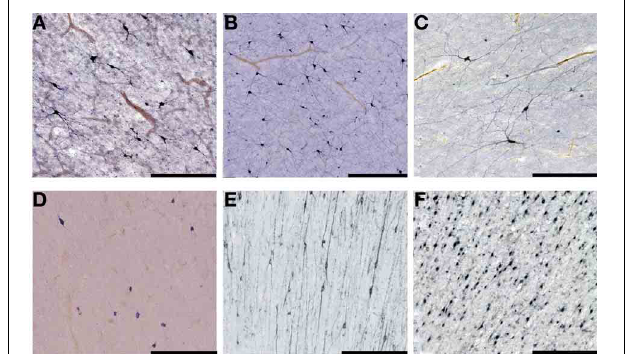
FIGURE 5 | Higher magnification view of subplate and white matter interstitial neurons displayed in panels A–F of the Figure 4 and stained for NOS (NADPH-diaphorase-stained neurons in A–D), MAP2 (E) and NeuN (F). Note that dendritic arborizations of subplate/interstitial neurons continue to grow and develop even after the disapearance of the subplate zone during the first year of life (compare ( A and B with C ). (A) , 37PCW; (B) , 13 days; (C) , 12 years; (D) , 57 years; (E) , 13 months; (F) , 51 years. Bar =